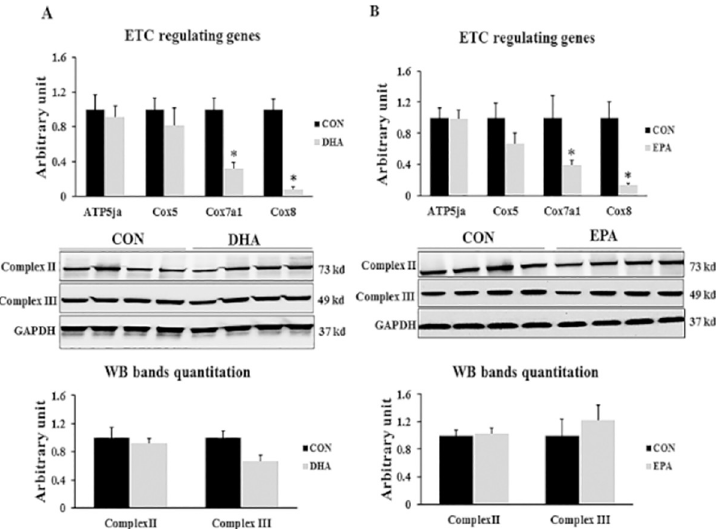
Fig 8. The effect of DHA and EPA on ETC regulating genes. C2C12 cells were treated with white adipogenesis induction differentiation medium (BIDM) in the absence (CON) or presence of individual doses of 50 μ M EPA and 50 μ M DHA for 7 days. All the values of RT-qPCR are normalized to the expression levels of 18s genes and calculated in arbitrary units, n = 6. Data are represented as mean ± SEM. The significant difference is presented as � P < 0.05, Student’s t test. The level of GAPDH is used as a housekeeping gene to normalize the Western blots data. (A) Effect of DHA on the expression of ETC regulating genes. (B) Effect of EPA on the expression of ETC regulating genes.